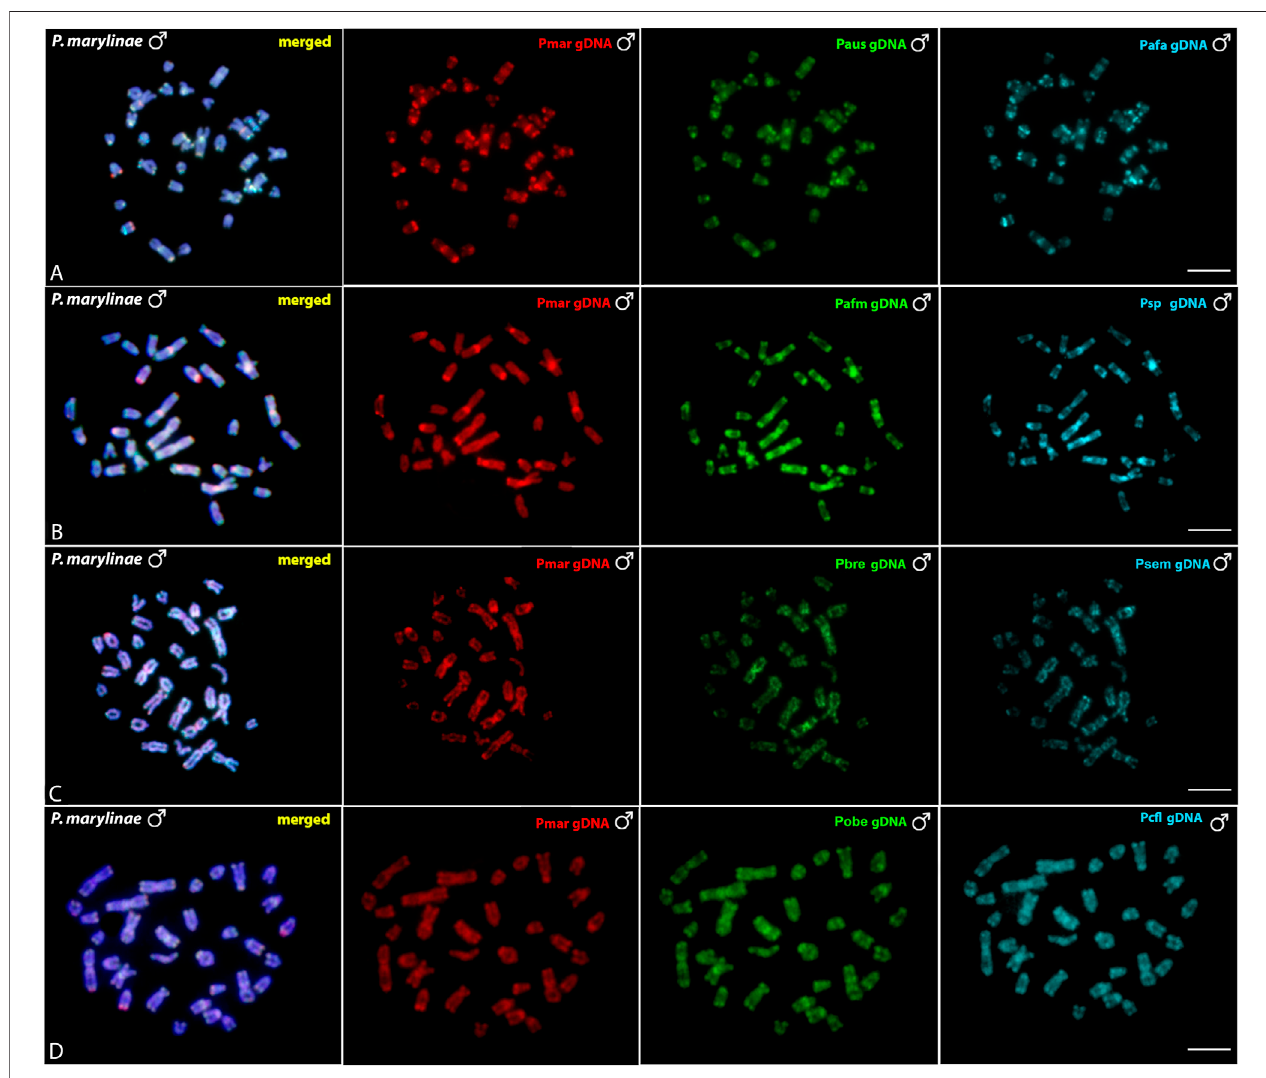
FIGURE 5 | Comparative genomic hybridization (CGH) using male-derived genomic probes from Pyrrhulina species hybridized onto male chromosomes of P. marilynae . The common genomic regions are depicted in the 1 st column in each linerepresenting the experimentsA-D. Hybridization between the gDNA of P. marilynae (Pmar), P. australis (Paus) and Pyrrhulina aff. australis (Pafa) (A) ; P. marilynae (Pmar), Pyrrhulina aff. marilynae (Pafm) and Pyrrhulina sp. (Psp) (B) ; P. marilynae (Pmar), P. brevis (Pbre) and P. semifasciata (Psem) (C) ; P. marilynae (Pmar), P. obermulleri (Pobe) and Pyrrhulina cf. laeta (Pc fl ) (D) . Bar (cid:1) 5 μ m.